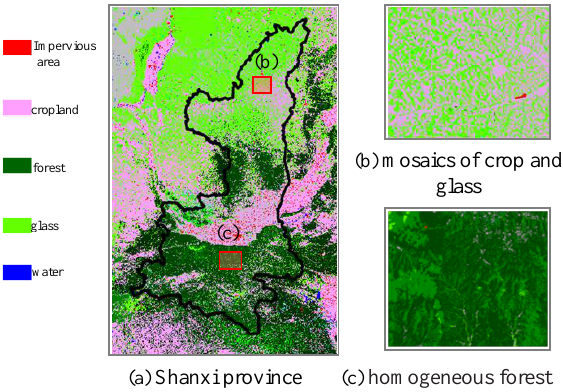
Figure 4. The land cover data in Shanxi province